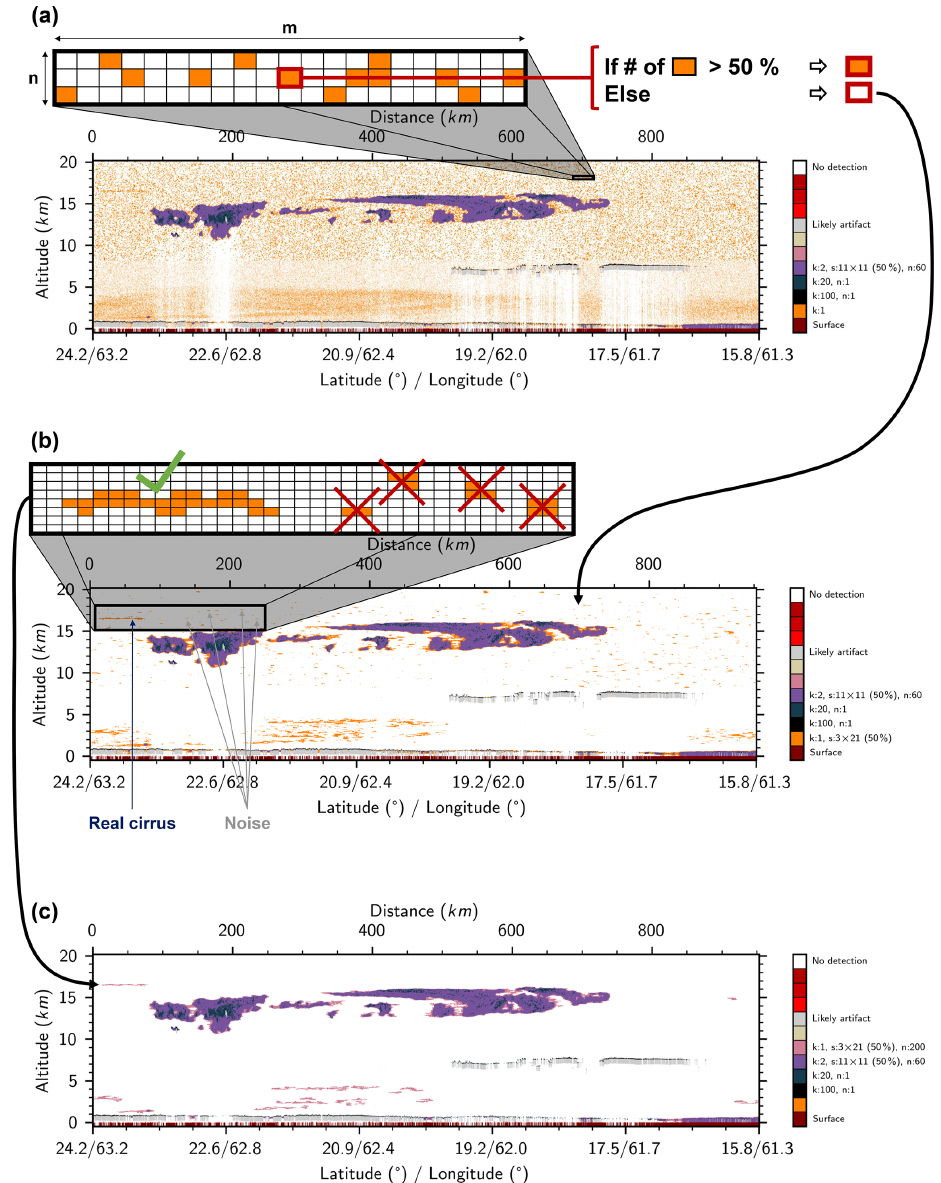
Figure 6. Illustration of the horizontal spatial coherence test window substep and the pattern size threshold rejection substep of 2D-McDA on the 532nm parallel channel for the case study shown in Fig. 1. (a) Pixels which are over the detection threshold given by Eq. (6) with the value of k = 1 (orange). (b) Result after applying a 3 × 21 spatial coherence test window on the detected pixels. (c) Result after rejecting all patterns composed by less than n = 200 pixels (note that the insert at the top is just an illustration and does show the real content of the image portion). Before these substeps, surface is detected first (brown); then, a very strong signal ( k = 100) occurring on highly reflecting liquid clouds is detected (black) and the 600m below is flagged as “likely artifact” (gray), as it is the region where we see artifacts due to the time response of photomultiplier tubes (PMTs) in the 532nm channels. Two detections were also made: one with k = 20 and another with k = 2, a 11 × 11 spatial coherence test window and n =